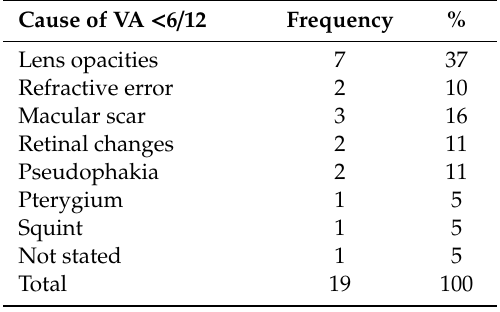
Table 2. Prevalence and causes of visual loss (presenting visual acuity (VA) < 6 / 12 in one or both eyes). Cause of VA < 6 / 12 Frequency % Lens opacities 7 37 Refractive error 2 10 Macular scar 3 16 Retinal changes 2 11 Pseudophakia 2 11 Pterygium 1 5 Squint 1 5 Not stated 1 5 Total 19